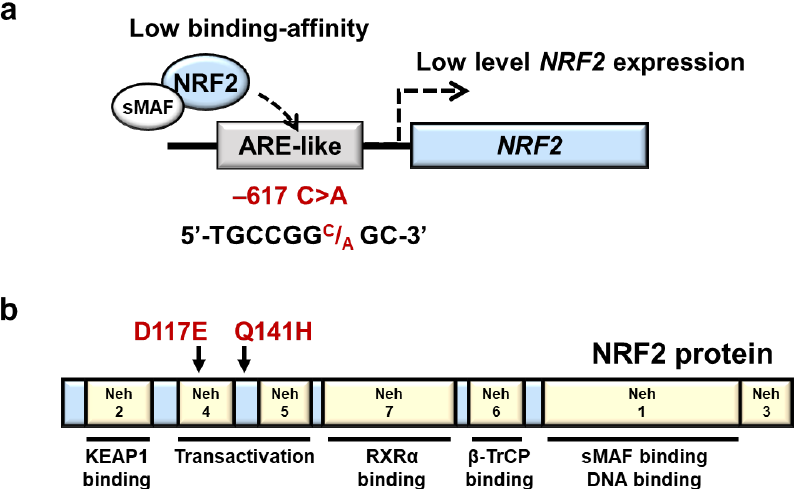
Figure 5. A regulatory SNP and two nonsynonymous SNPs in the NRF2 gene. ( a ) Location of NRF2 rSNP-617 in the ARE-like motif in the upstream promoter region of the NRF2 gene. rSNP −617 C>A decreases the affinity of NRF2 binding to the ARE-like motif. ( b ) Location of nonsynonymous NRF2 SNPs associated with NRF2 domain structures. Human NRF2 protein contains 7 Neh domains. Neh, Nrf2-ECH homology.